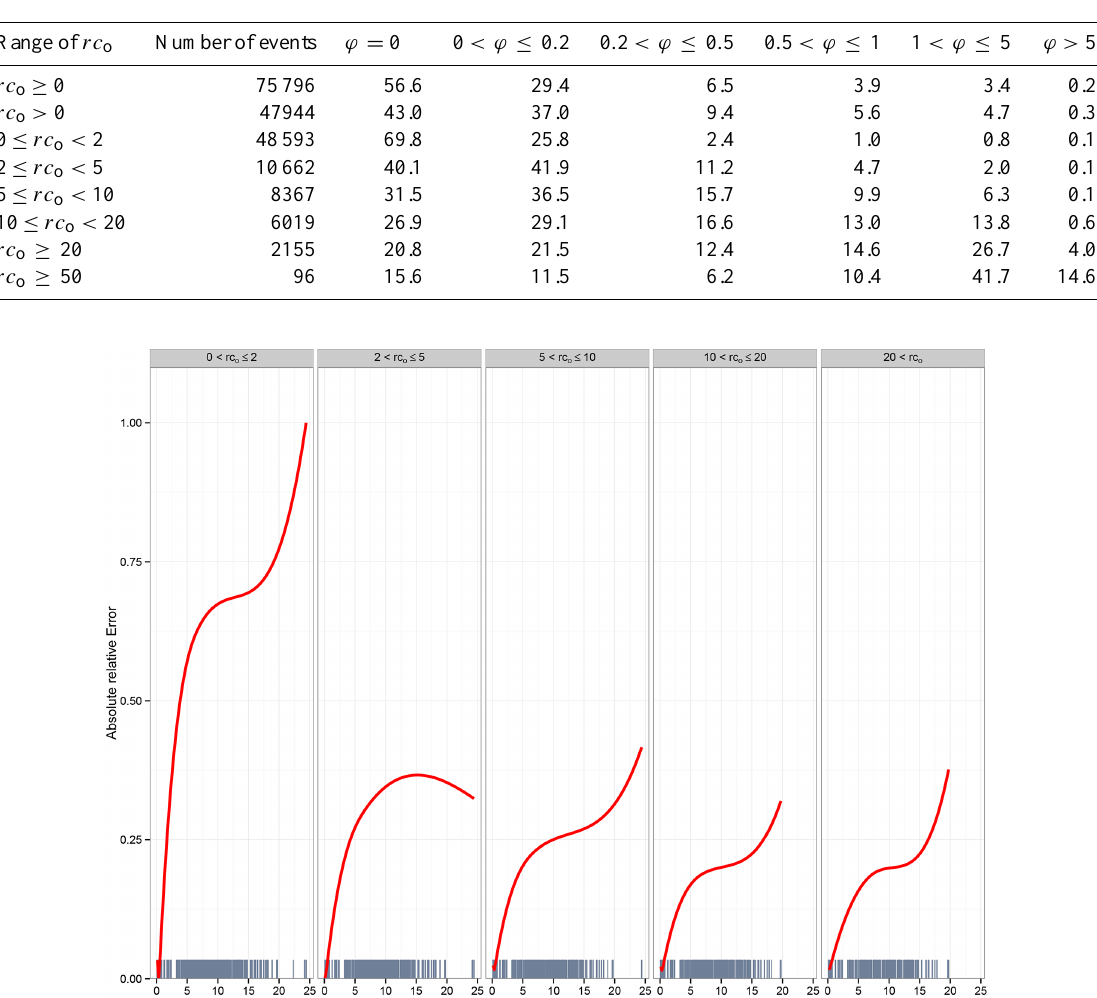
Figure 9. Median absolute relative error represented as a function of the distance to the closest rain gauge for different observed rainfall event ranges. The grey lines along the x axis indicate the distance between the tipping bucket and the closest rain gauge used in the estimation procedure. Analysis carried out on the full Scottish validation data (138 tipping bucket rain gauges) including the days when the tipping bucket was at less than 5km away from the daily gauges used to derive the rainfall